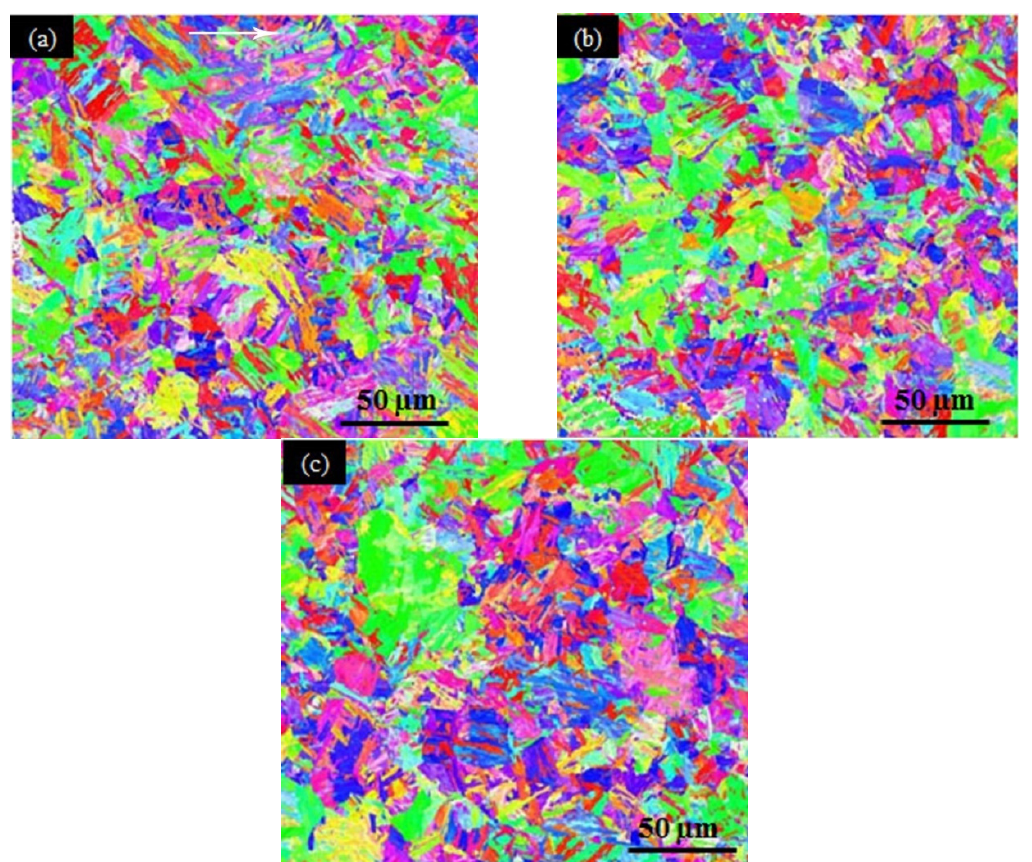
Figure 5. EBSD (electron backscattering diffraction) orientation maps of the nitrided sample at different depths: ( a ) 20 µm–210 µm from the surface; ( b ) 200 µm–390 µm from the surface; ( c ) 390 µ m–580 µ m from the surface.